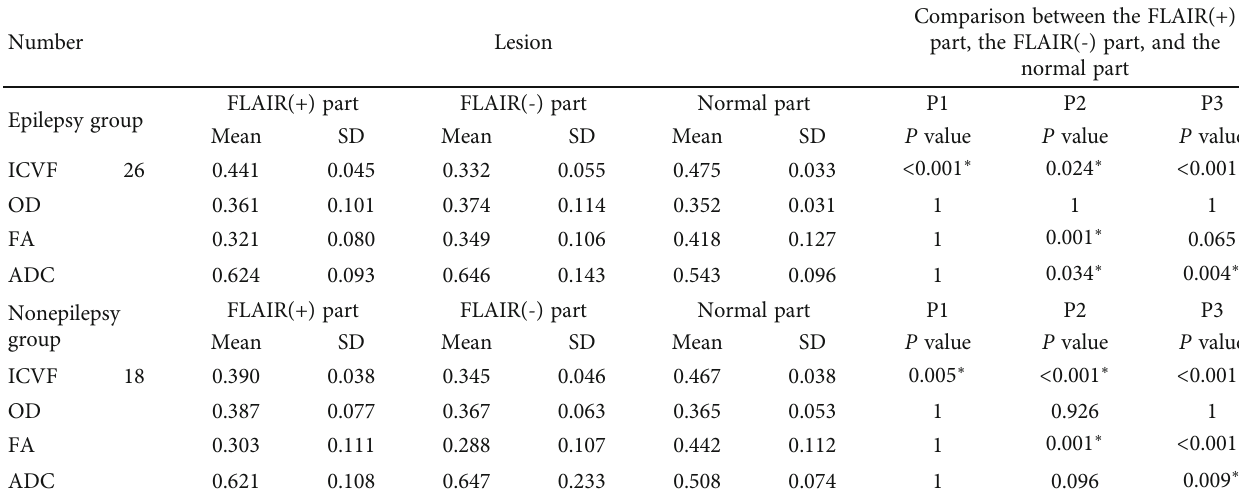
∗ indicates that the di ff erence of the means is signi fi cant at the 0.05 level. Table 4: NODDI parameter comparison of FLAIR hyperintense lesions and FLAIR hypointense lesions in both the epilepsy and nonepilepsy